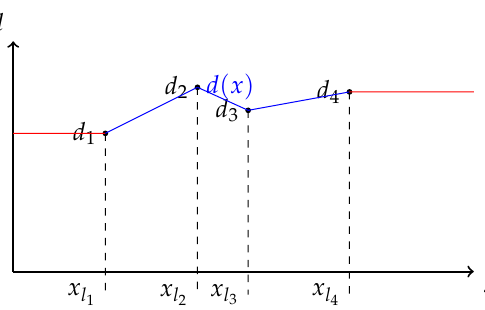
Figure A1. Distance function d ( x ) along a single row constructed using known distances for emission lines l 1 , ..., l 4 . Linearly interpolated region are shown in blue, extrapolated regions in red. In this case, extrapolation just assumes the closest known